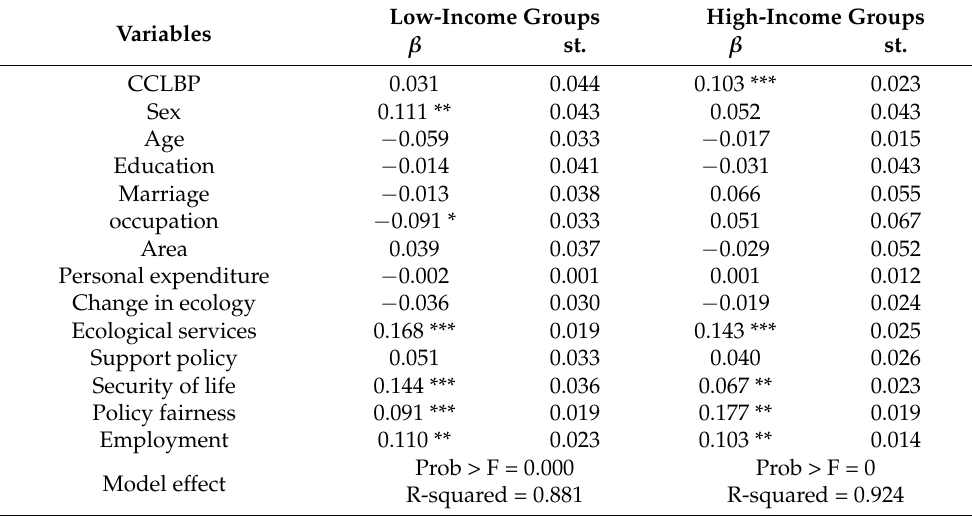
Table 8. Regression results of life satisfaction in different income